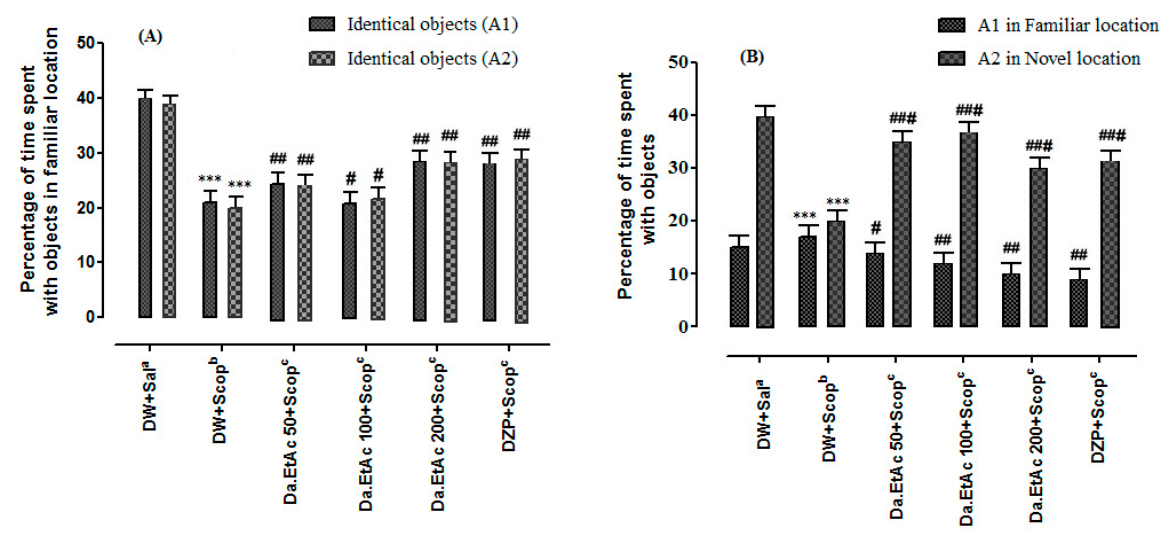
Figure 5. Effect of Fa.EtAc fraction of Ferula ammoniacum (D. Don) on mice in behavioural NOL task ( A ) Percent exploration time between the objects A1 and A2 in familiar location in the sample phase ( B ) Percent exploration time between the objects A1 and A2 in novel location in the test phase. The data are expressed as Mean ± SEM; each value corresponds to a mean of eight animals. One-way ANOVA followed by Dunnett’s post hoc multiple comparison test to determine the values of p . *** p < 0.001, # p < 0.05, and ## p < 0.01 and ### p < 0.001; comparison of A1 (Object in familiar location) vs. A2 (Object in novel location).